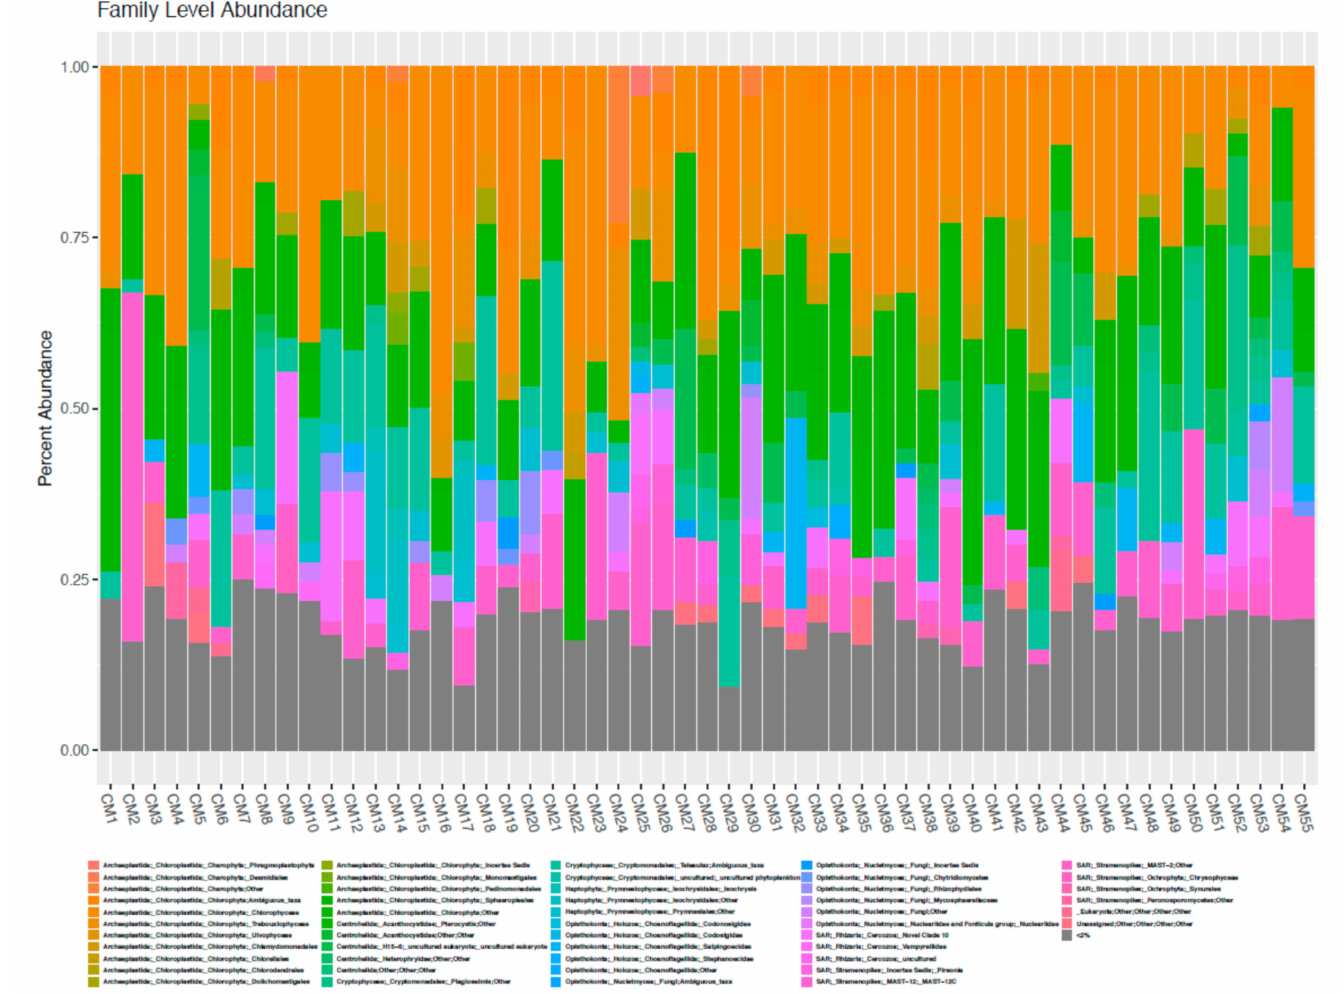
Figure 4. Alpha diversity at the Family level for OTU